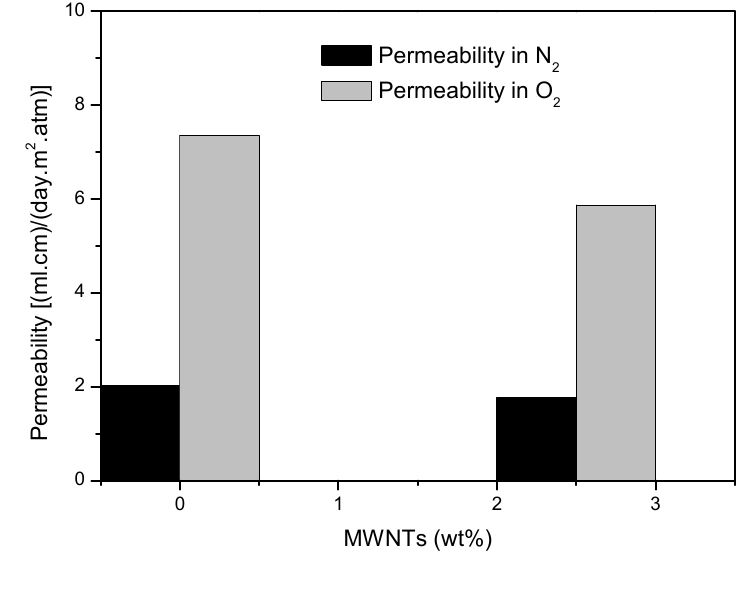
Figure 34. Permeability of O 2 and N 2 from iPP/MWCNTs nanocomposites containing 2.5 wt %